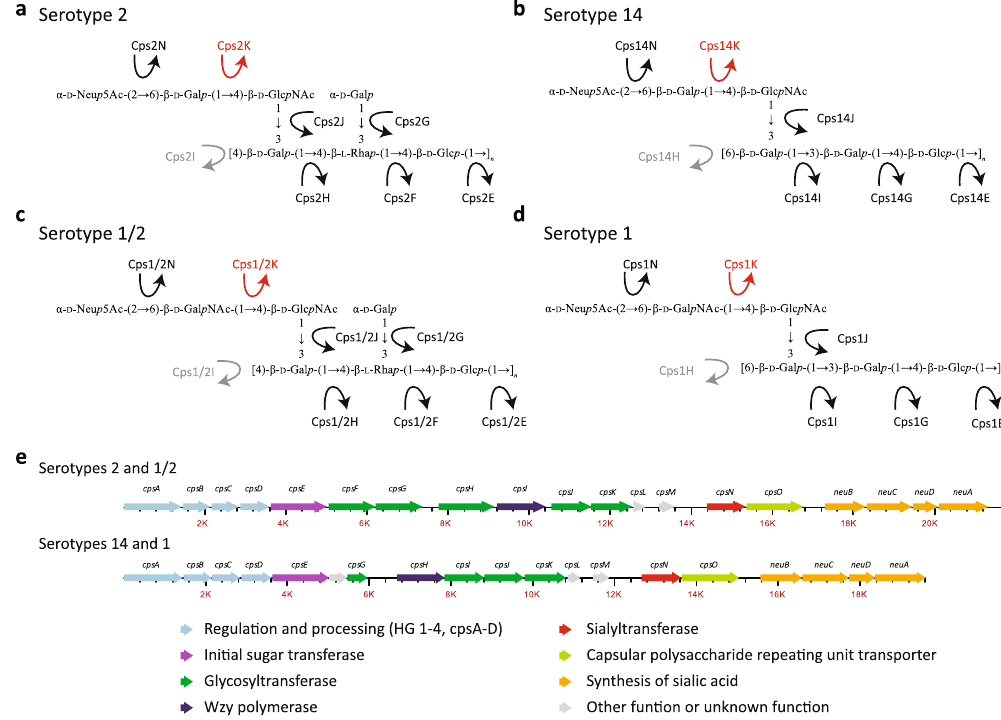
Figure 1. Capsular polysacharide structures of S. suis serotypes 2, 1/2, 14, and 1, and schematics of the cps loci of these serotypes. ( a – d ) CPS structures of serotype 2 ( a ), serotype 14 ( b ), serotype 1/2 ( c ), and serotype 1 ( d ). In serotypes 1 and 1/2, CpsK is predicted to catalyze the transfer of the side chain N -acetylgalactosamine (GalNAc) residue to the CPS repeating unit, while in serotypes 2 and 14, CpsK would catalyze the transfer of the galactose (Gal) residue at the same corresponding side chain. ( e ), All enzymes involved in CPS biosynthesis, including CpsK, are encoded by genes located in a single cps locus. Serotypes 2 and 1/2 and serotypes 14 and 1 have identical CPS gene content and organization. The putative functions of the enzymes encoded by cps genes are depicted with different colors. Please note that Cps enzymes (and cps genes) have been renamed compared to previous publications 11, 14, 16–19 to reflect recent developments in actual or predicted